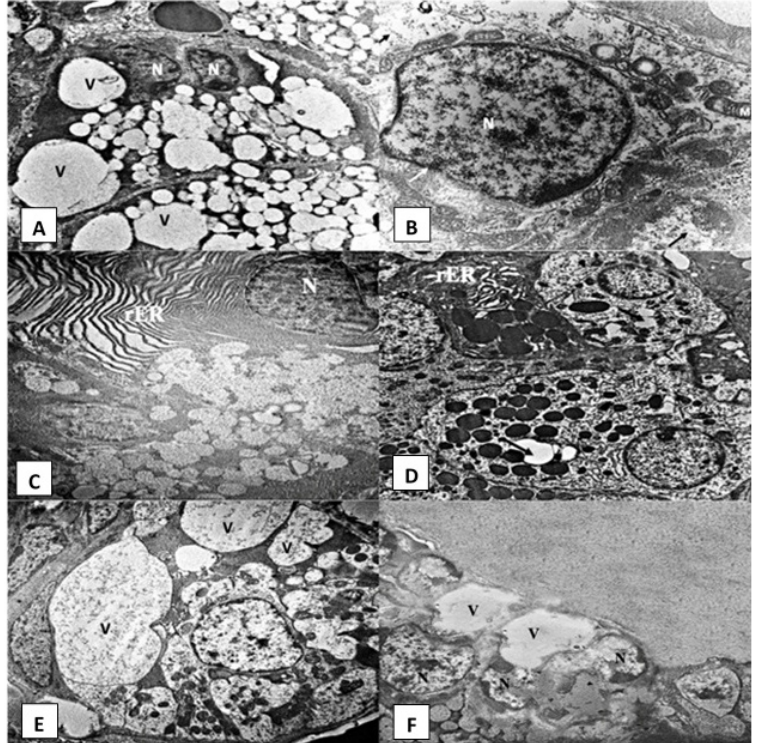
Figure 3. Electromicrographs of the AFB1 group showing ( A ) serous acinus with different sized intracytoplasmic vacuolations (V) and shrunk nuclei (N) (uranyl acetate and lead x 5000). ( B ) Open face nucleus of serous acinar cell (N) with irregular nuclear membrane (white arrows). Radially arranged mitochondria (M) with dilated cristae and vacuoles. Degenerated cytoplasm (black arrows) can be noticed (uranyl acetate and lead x 12000). ( C ) Serous cell with irregular nuclear membrane (N) & dilated rough endoplasmic reticulum (rER) (uranyl acetate and lead x 5000). ( D ) Granular convoluted tubule cells with intracytoplasmic vacuolations (arrows) and dilated rER (uranyl acetate and lead x 4000) ( E ) Striated duct with indistinct cell outline and numerous large intracytoplasmic vacuolations (V) pressing on the cell nucleus and loss of basal striations in some cells (uranyl acetate and lead x 5000). ( F ) Excretory duct cells showing cytoplasmic vacuolations (V) and nuclei (N) with irregular outline (uranyl acetate and lead x